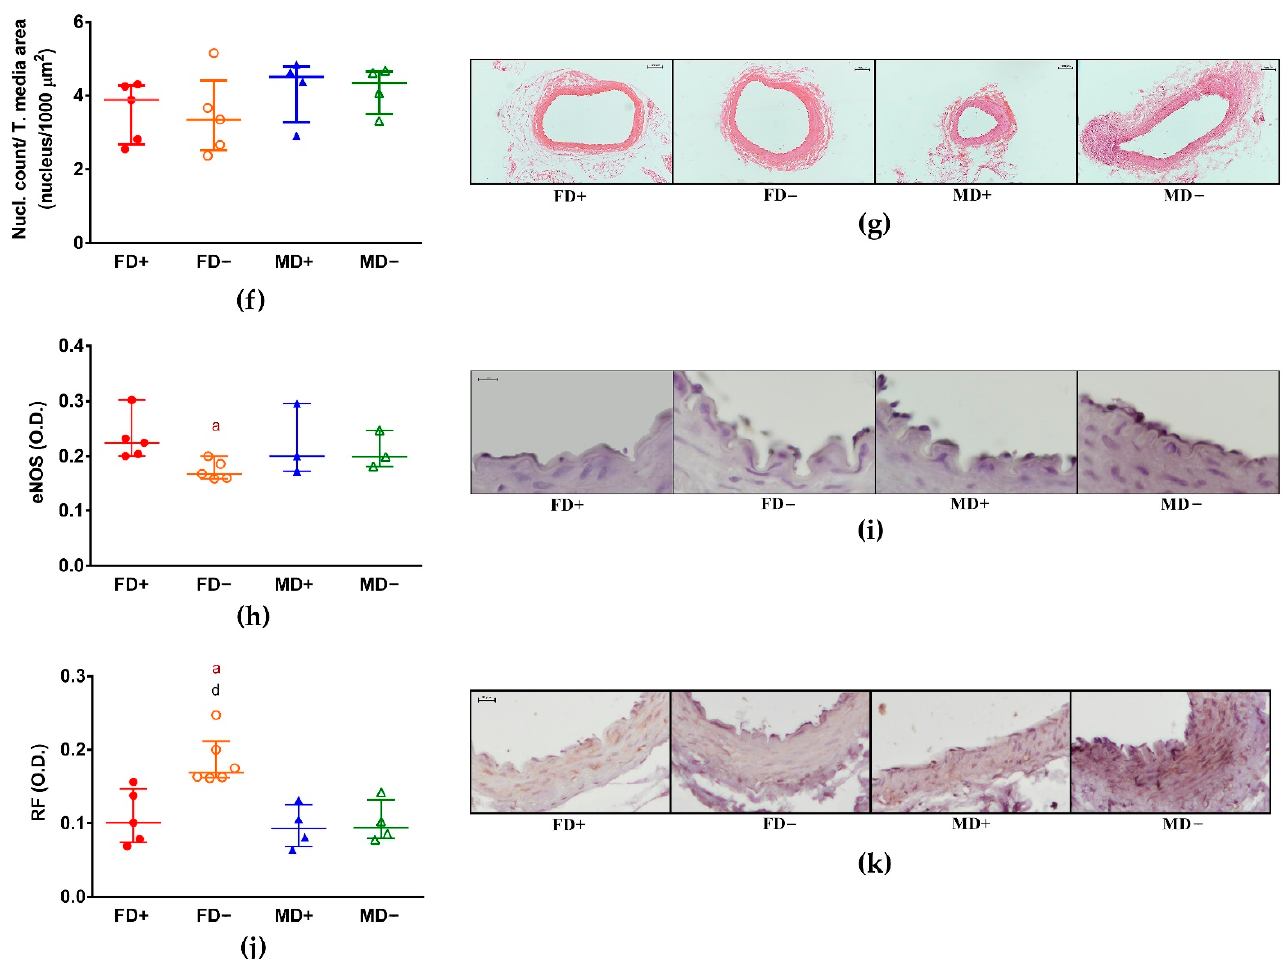
Figure 3. Histology of the renal arteries: (a) Intima/media ratio of the renal arteries measured on resorcin-fuchsin stained tissue sections. There were no significant effect of gender or Vitamin D deficiency on intima/media ratio, neither was any intergroup difference; (b) Density of resorcin-fuchsin staining in the media layer of renal arteries. FD– group had significantly augmented staining intensity compared to the FD+ and MD+ groups; (c) Representative images of resorcin-fuchsin stained renal arteries (scale bar is 20 µm); ( d ) α -smooth muscle actin ( α -SMA) immunohistochemistry of renal arteries. The MD+ group showed significantly higher SMA staining intensity compared to the FD+ and FD– groups; (e) Representative images of renal arterial sections stained against α -SMA (scale bar is 20 µm). In all immunohistochemical stainings, brown-colored diamino-benzidine represents specific labeling and blue-colored hematoxylin was used for counterstaining; (f) Density of smooth muscle cell nuclei in the media layer of renal arteries. Between experimental groups, there were no significant difference in the number of smooth muscle nuclei per 1000 µm 2 . (g) Representative images of hematoxylin-eosin stained tissue sections (scale bar is 100 µm). (h) eNOS immunohistochemistry of renal arteries. eNOS specific labeling intensity was significantly lower in FD– rats compared to the FD+ animals; (i) Representative images of renal arterial sections stained against eNOS (scale bar is 10 µm); (j) Angiotensin II receptor-1 (AT 1 R) immunohistochemistry of renal arteries. AT 1 R specific staining showed the highest intensity in MD– experimental group, it differed significantly from the staining intensity measured in FD– animals; (k) Representative images of renal arterial sections stained against AT 1 R (scale bar is 20 µm). Data are shown as median [IQR]; N = 3–6 in each group; a: p < 0.05, aa: p < 0.01 FD+ vs. FD–; b: p < 0.05 FD+ vs. MD+; d: p < 0.05 FD– vs. MD+; e: p < 0.05 FD– vs. MD–.